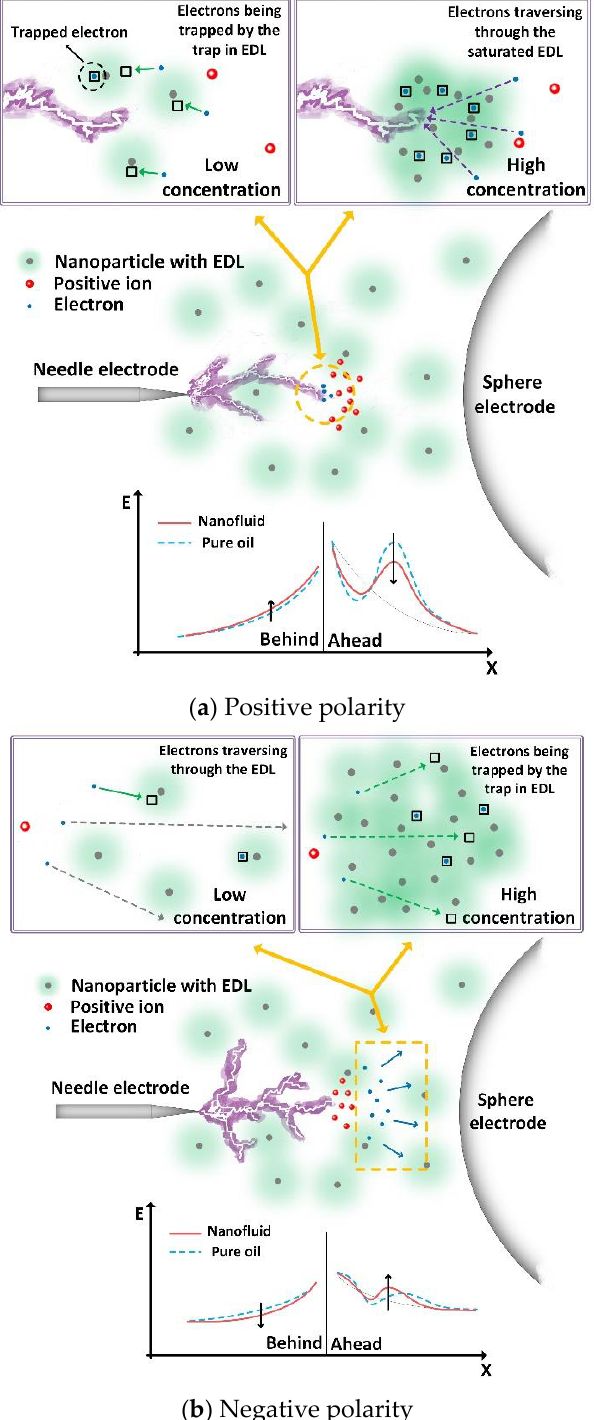
Figure 10. Streamer propagation model for indicating the effect of TiO 2 concentration level on breakdown characteristics of nanofluid.